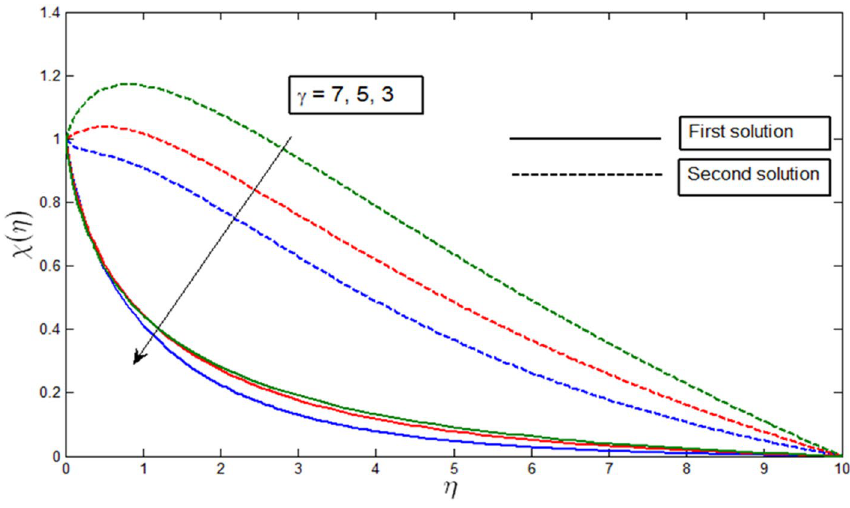
Figure 12. Microorganism profile χ(η) for various γ when (cid:31) = − 4, Lb = 0.5, Le = 1, Pb = 0.5, Nr = 0.5, Rb = 0.6, A = 0.2.